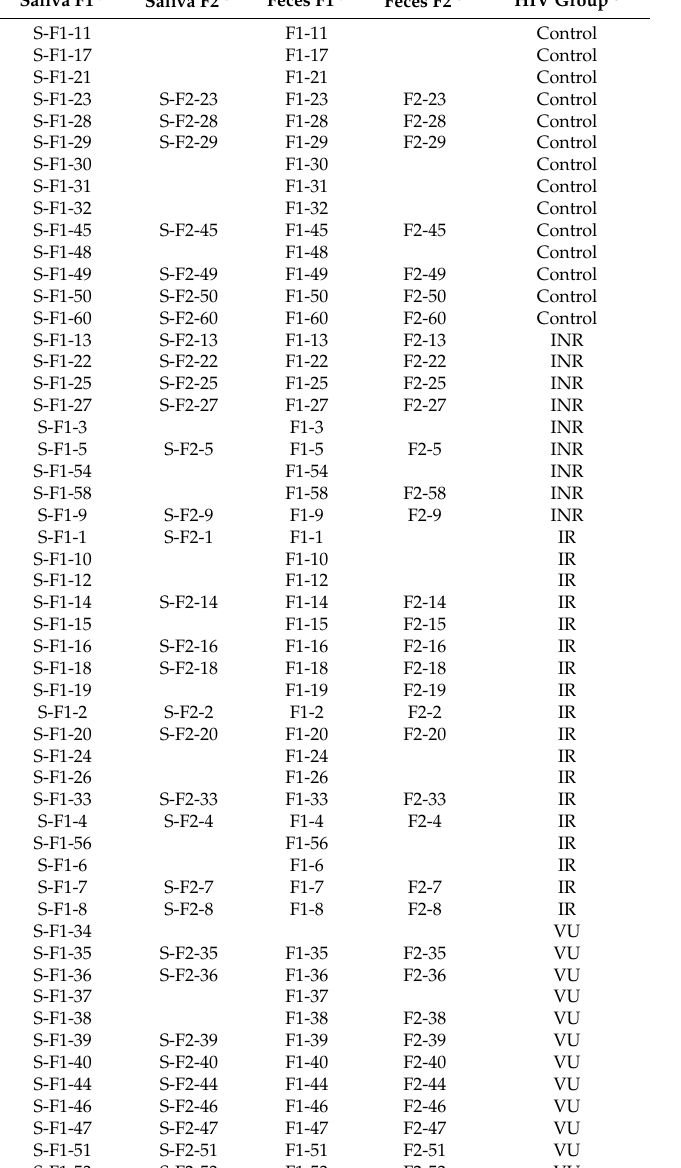
Table 1. Saliva and fecal samples used in the